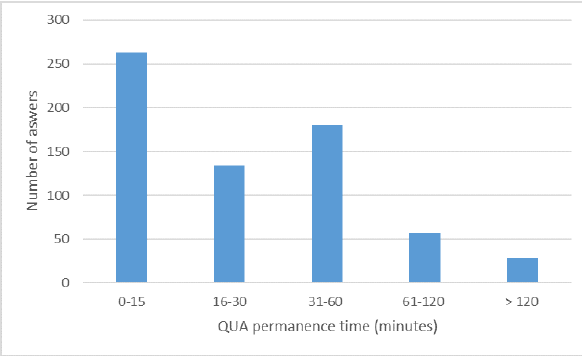
Figure 5: Evaluation of the permanence time in selected pilot areas from end–user